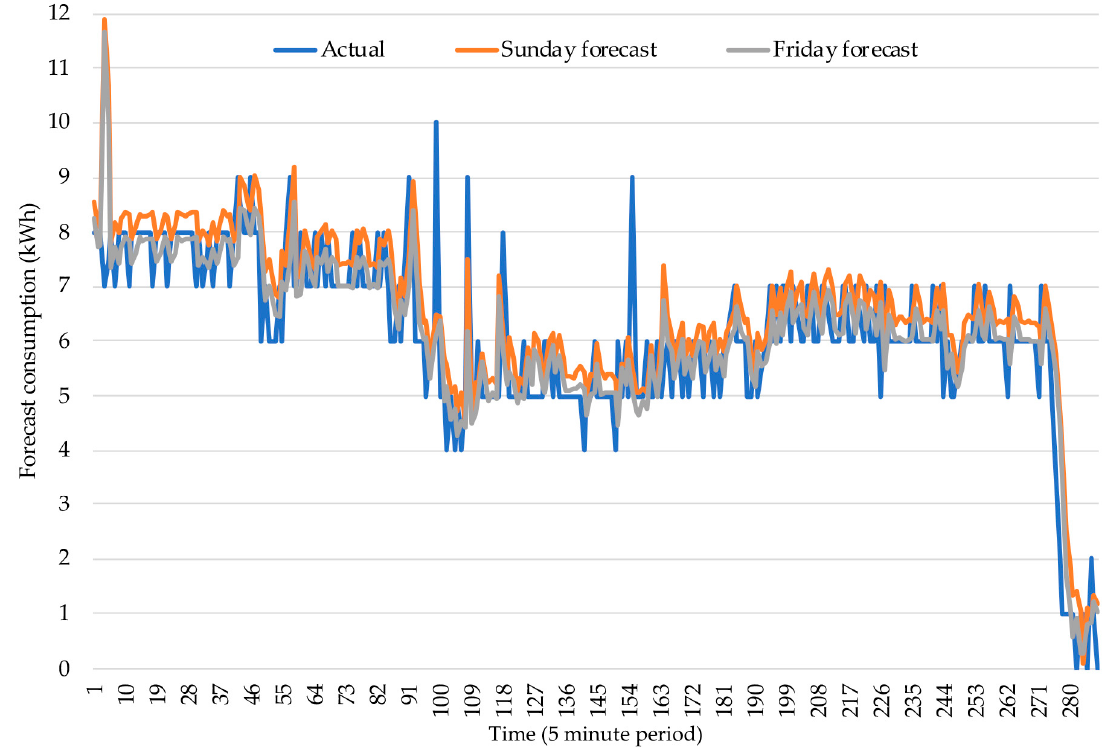
Figure 9. Actual and forecasted consumption for 13 April 2019.